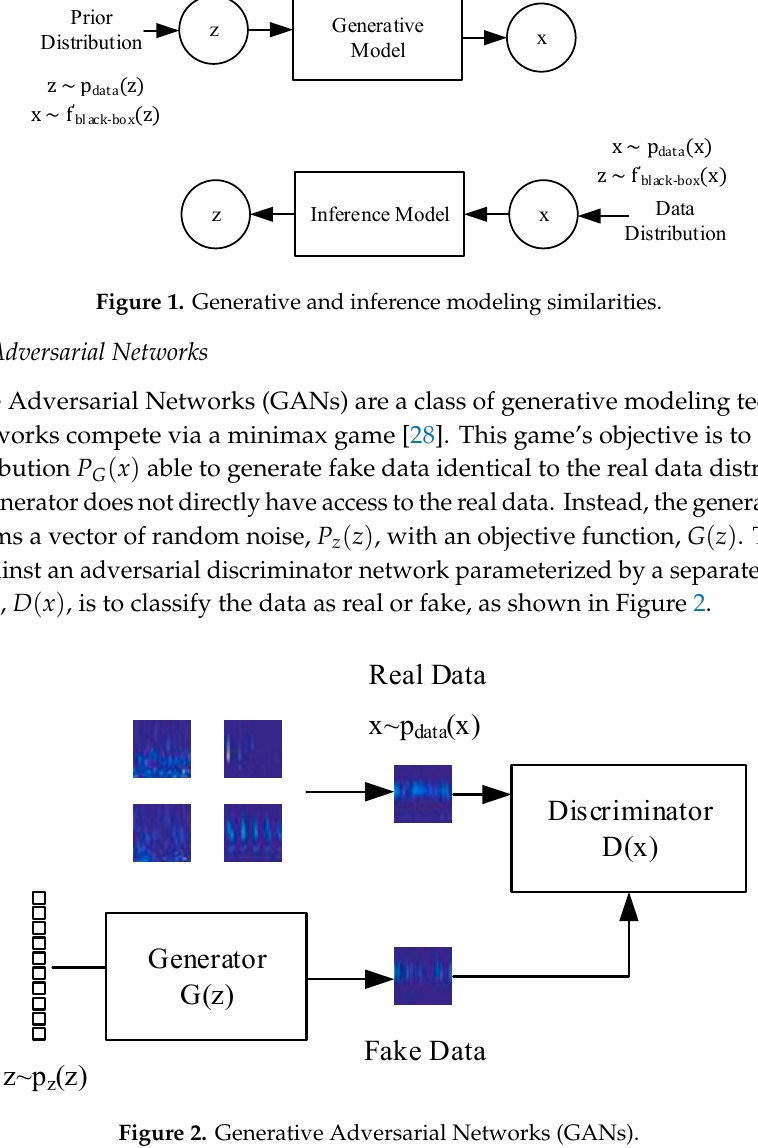
Figure 2. Generative Adversarial Networks (GANs).